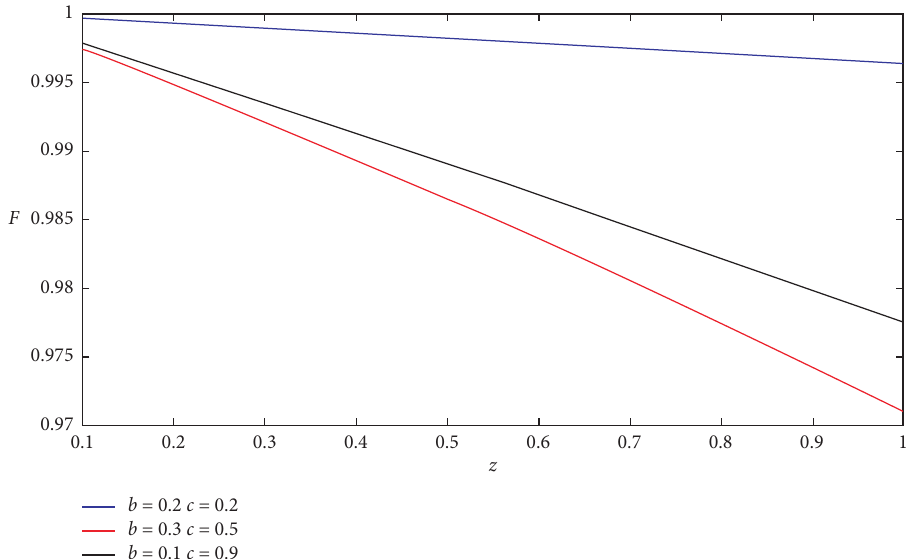
Figure 3: The graph of CDF for equation (33); we take three cases of the values of the parameters: first case b � c � 0 . 2, second case b � 0 . 3 and c � 0 . 5, and final case b � 0 . 1 and c � 0 .